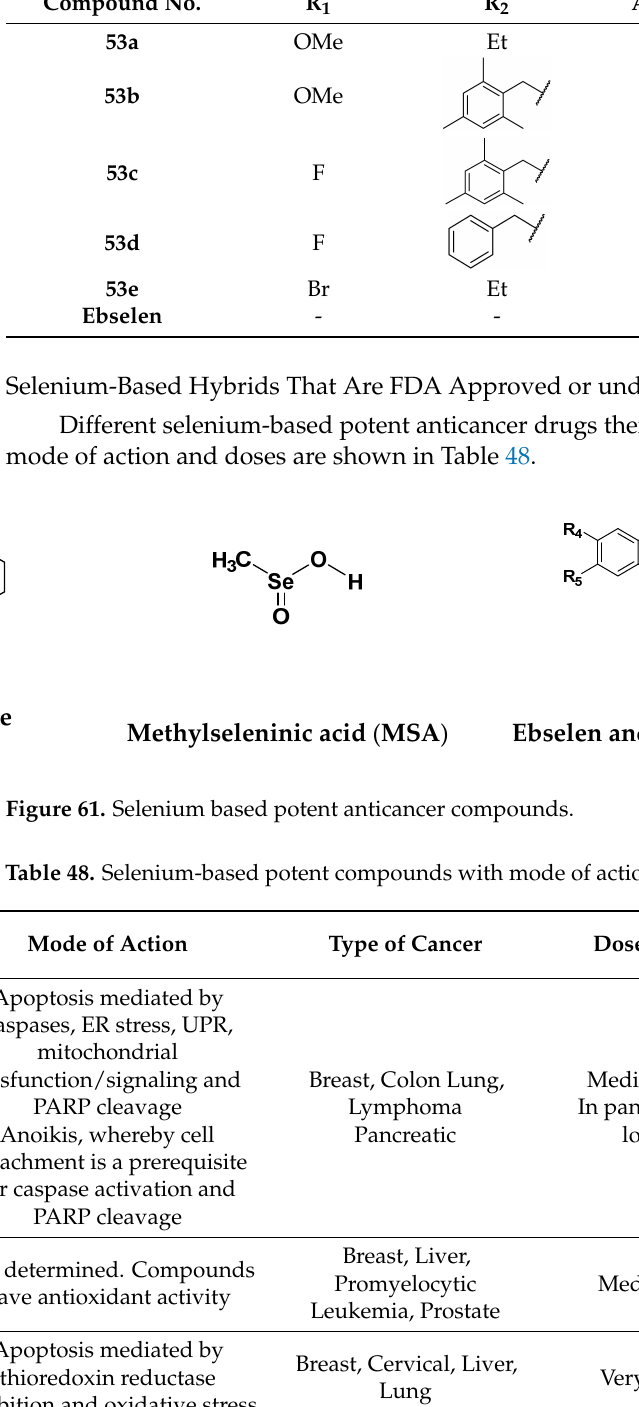
Figure 60. Structure of selenium-based diaryl imidazole hybrid derivatives ( 53 ). Table 47. In vitro cytotoxic activities of selenium based diaryl imidazole hybrid compounds 53 ( a – e ). Compounds No.